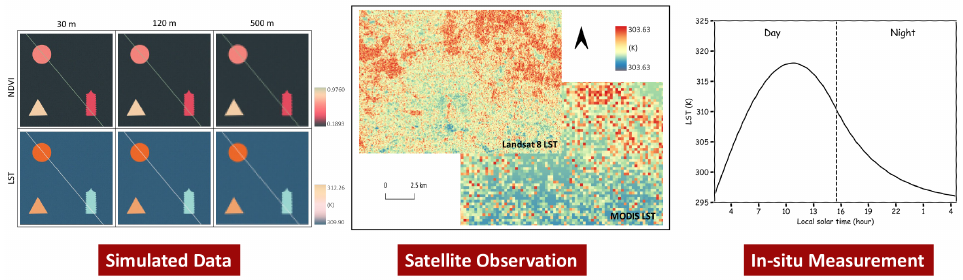
Figure 2. Examples of reference data to assess the LST enhancement